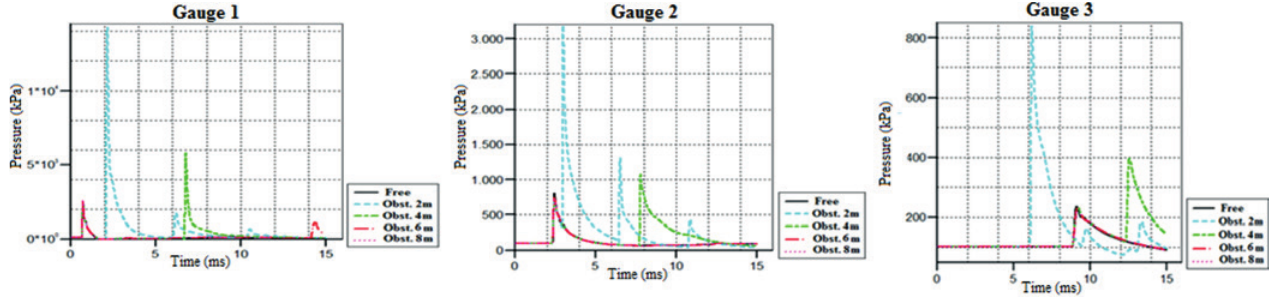
Figure 8 Blast wave pressure - time history from a 50 kg TNT charge